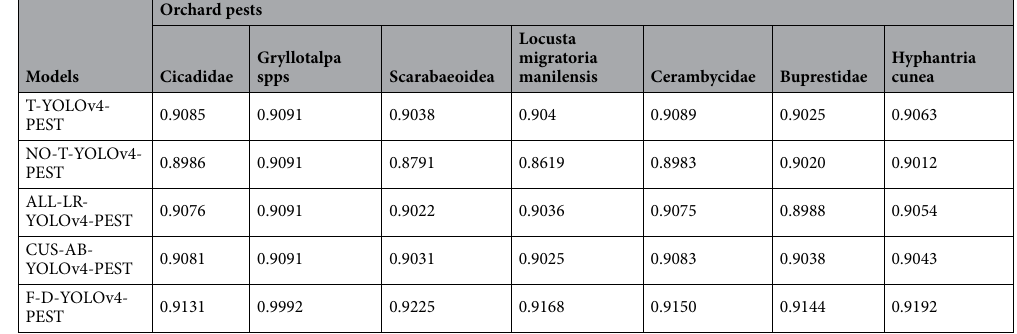
Table 8. The category detection AP of each model (IoU = 0.5).